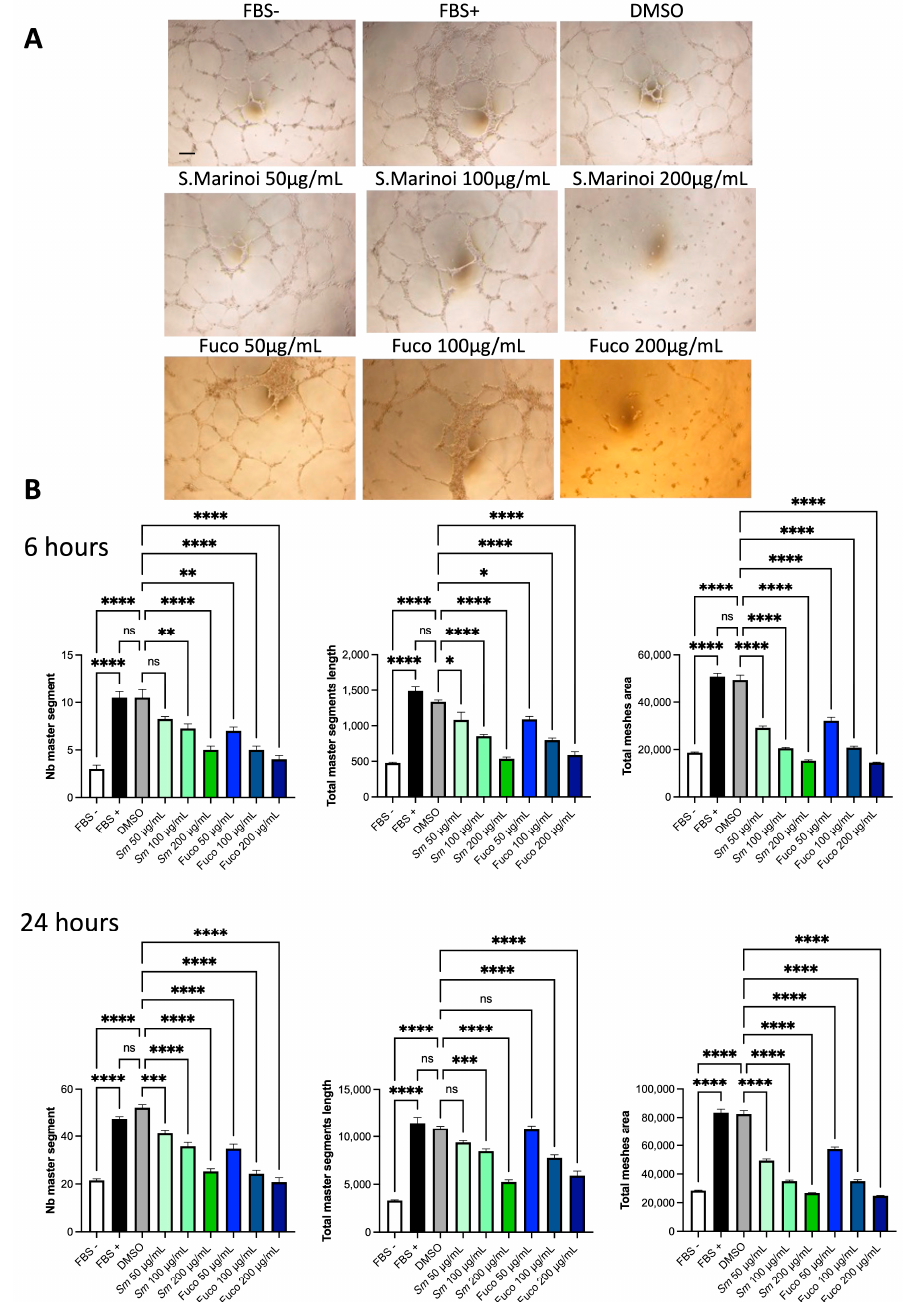
Figure 9. Effect of S. marinoi extract and fucoxanthin on capillary-like structure formation of HUVECs. Cells were placed in 96-well plates coated with a layer of Matrigel (2.5 × 10 3 per well) and treated with Sm and Fuco (50, 100, or 200 µ g/mL) or incubated with vehicle alone for 6 and 24 h. FBS -/-: cells cultured in serum-free EBM-2 medium, FBS +/+: cells grown in complete EBM-2 medium, were used as the negative and positive controls, respectively. ( A ) Microphotographs were taken at 5 × magnification, representative images are shown, scale bar 200 µ m. ( B ) Images were quantified by Angiogenesis Analyzer ImageJ tool kit. The number (Nb) of master segments as well as the total master segment length and total meshes area were evaluated. The e ff ect of Sm and pigment on HUVECs(cid:31) ability to form capillary-like structures on Matrigel was compared to vehicle-treated cells. Data are shown as mean ± SEM, one-way ANOVA, ns = not signi fi cant, * p < 0.05, ** p < 0.01, *** p < 0.001, **** p < 0.0001. ( n = 4).